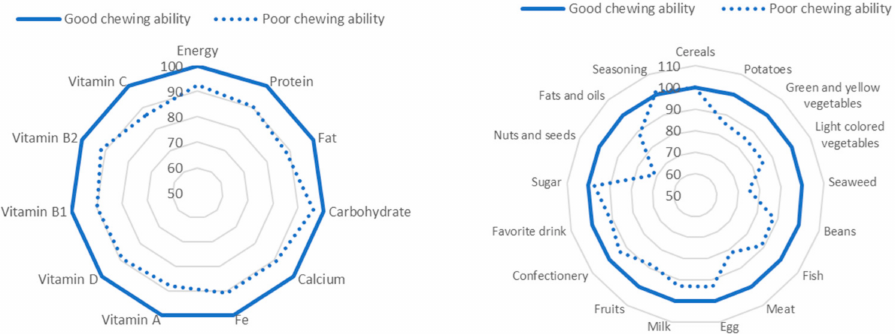
Figure 2. The difference between poor and good chewing ability when the good chewing ability is set to